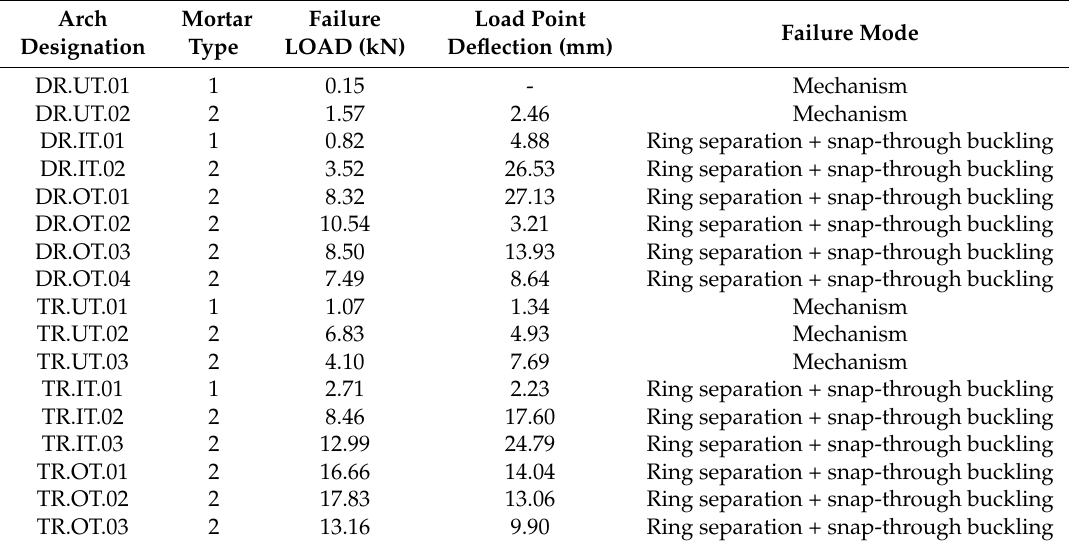
Table 2. Test results on masonry arches.